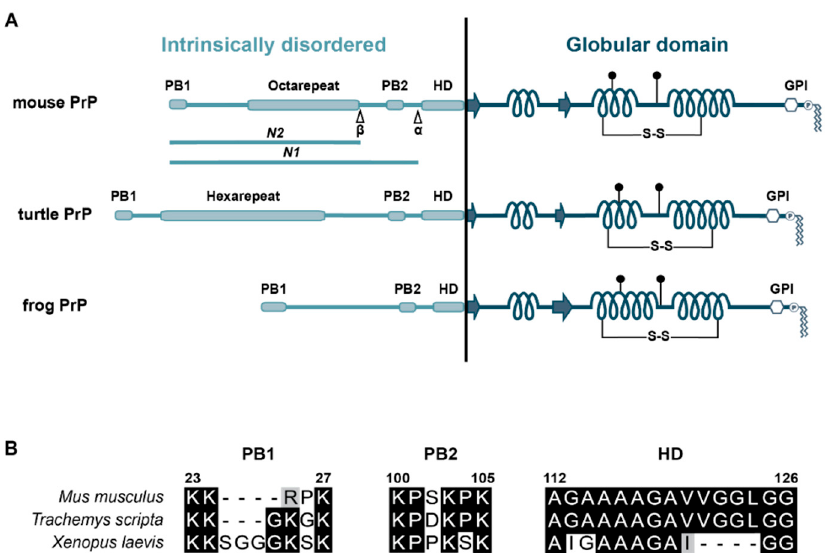
Figure 1. ( A ) Schematic representation of PrP C from mouse, turtle, and frog. PB: polybasic motif; β : cleavage site that generates N2; α : cleavage site that generates N1; HD: hydrophobic domain; arrows: β -strand; coils: α -helices; S-S: disulfide bridge; filled circles: N-linked glycans; GPI: glycosylphosphatidylinositol anchor. ( B ) Sequence alignments of PB1, PB2, and the HD. Identical residues are marked in black, similar residues in gray (GenBank accession numbers: M18070.1, XP_034617687.1, AAH94089.1). The numbering of the residues refers to mouse PrP C .